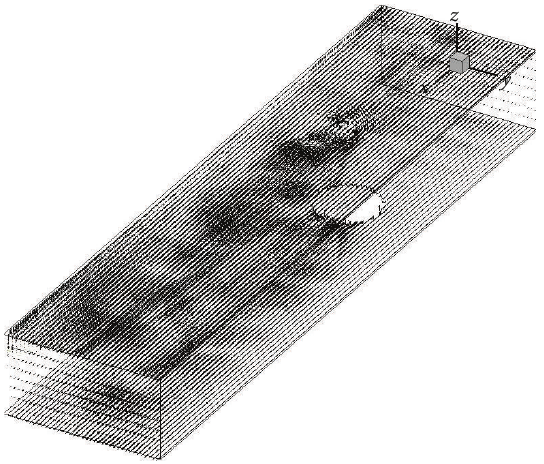
Figure 7: Velocity field vectors when the flow has been stabilized using the 𝑘 - 𝜖 + ml-06 turbulence model.